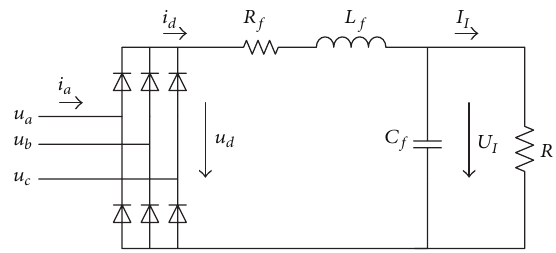
Figure 1: The structure diagram of equivalent simplified mode for EV charger [20].